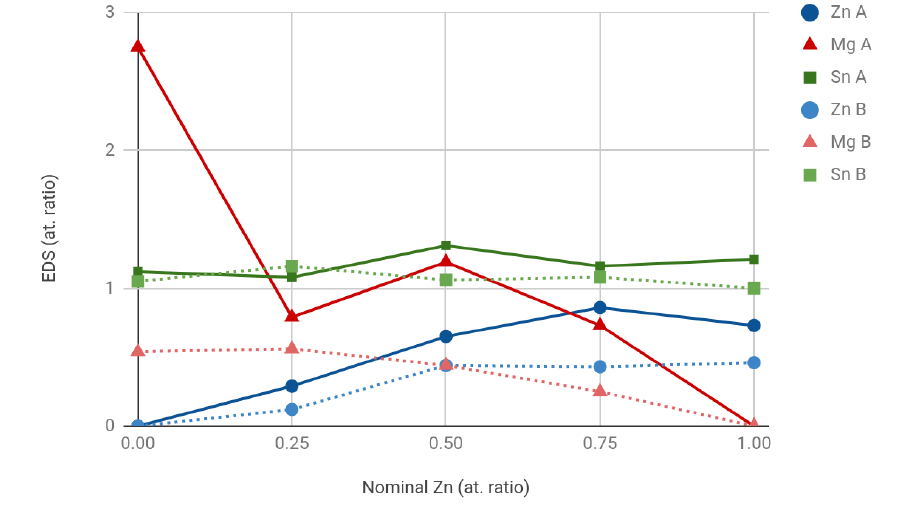
Figure 1. EDX atomic percentage trend for each nominal Zn content. Continuous lines correspond to KA series and dashed lines to KB series.